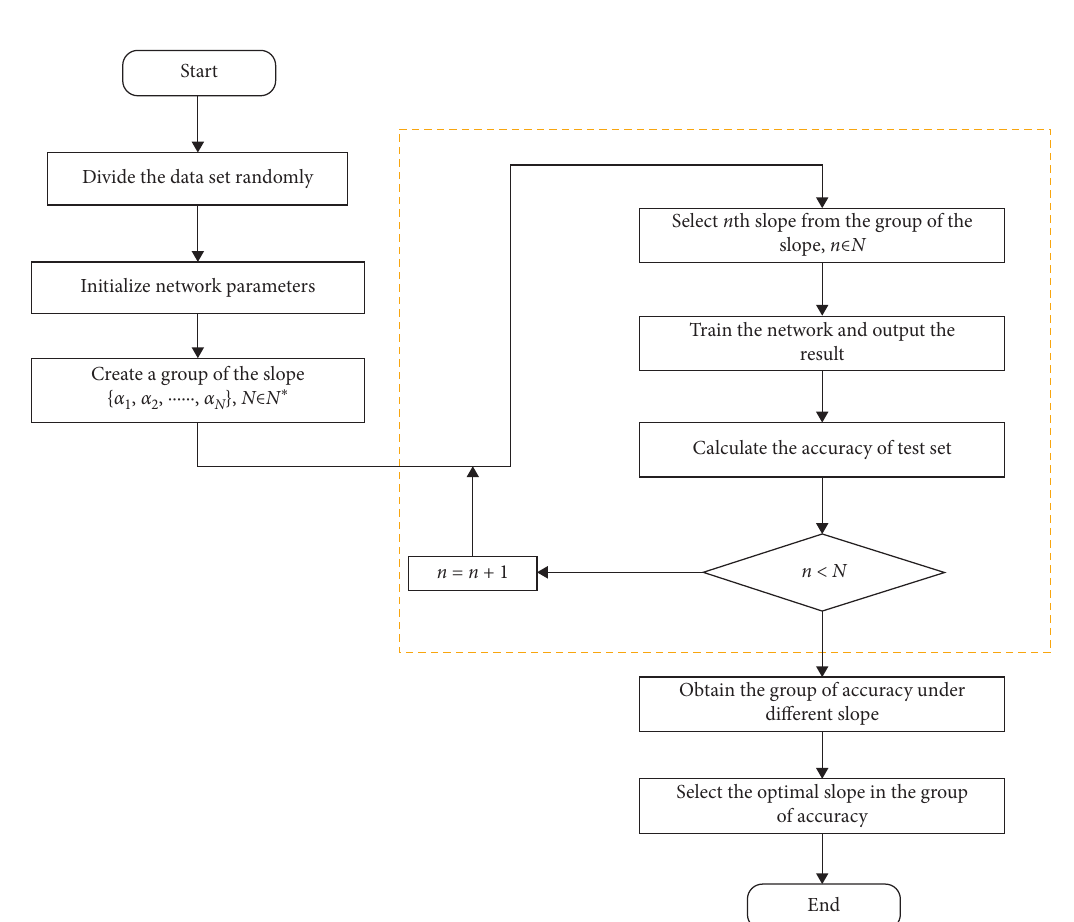
Figure 7: Flowchart of the proposed group searching method.